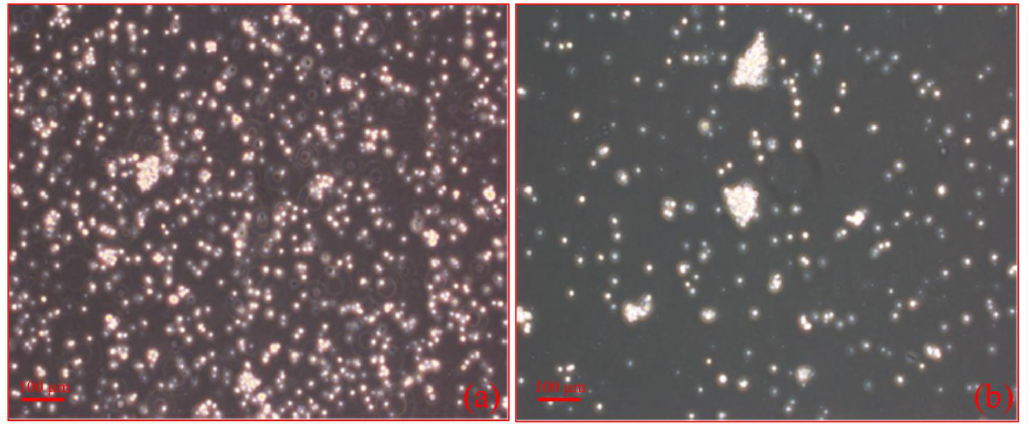
Figure 5. Cultured intestinal Peyer’s patch lymphocytes ( a ) before and ( b ) after the addition of 1000 ng/mL IFNβ.